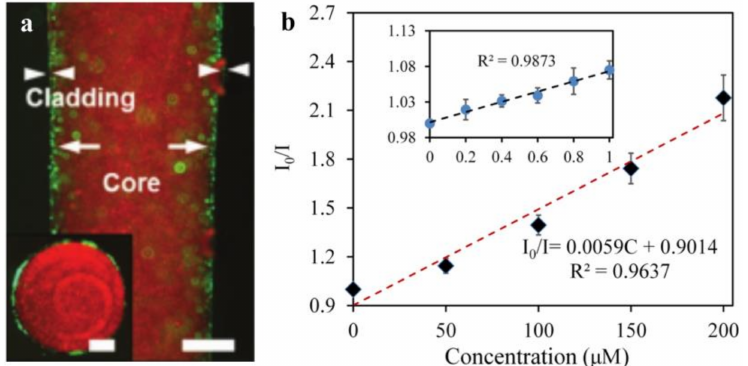
Figure 10. ( a ) A fluorescent image of the hydrogel fiber (scale bar = 500 µ m) and the inset image is the fiber cross-section (scale bar = 250 µ m). (Reprinted with permission from ref. [46]). ( b ) The calibration curve of the UCNPs-HOF fiber detecting DA in the range of 0–200 µ M, and the inset shows a linear plot in a small range (0–1 µ M). (Reprinted with permission from ref.